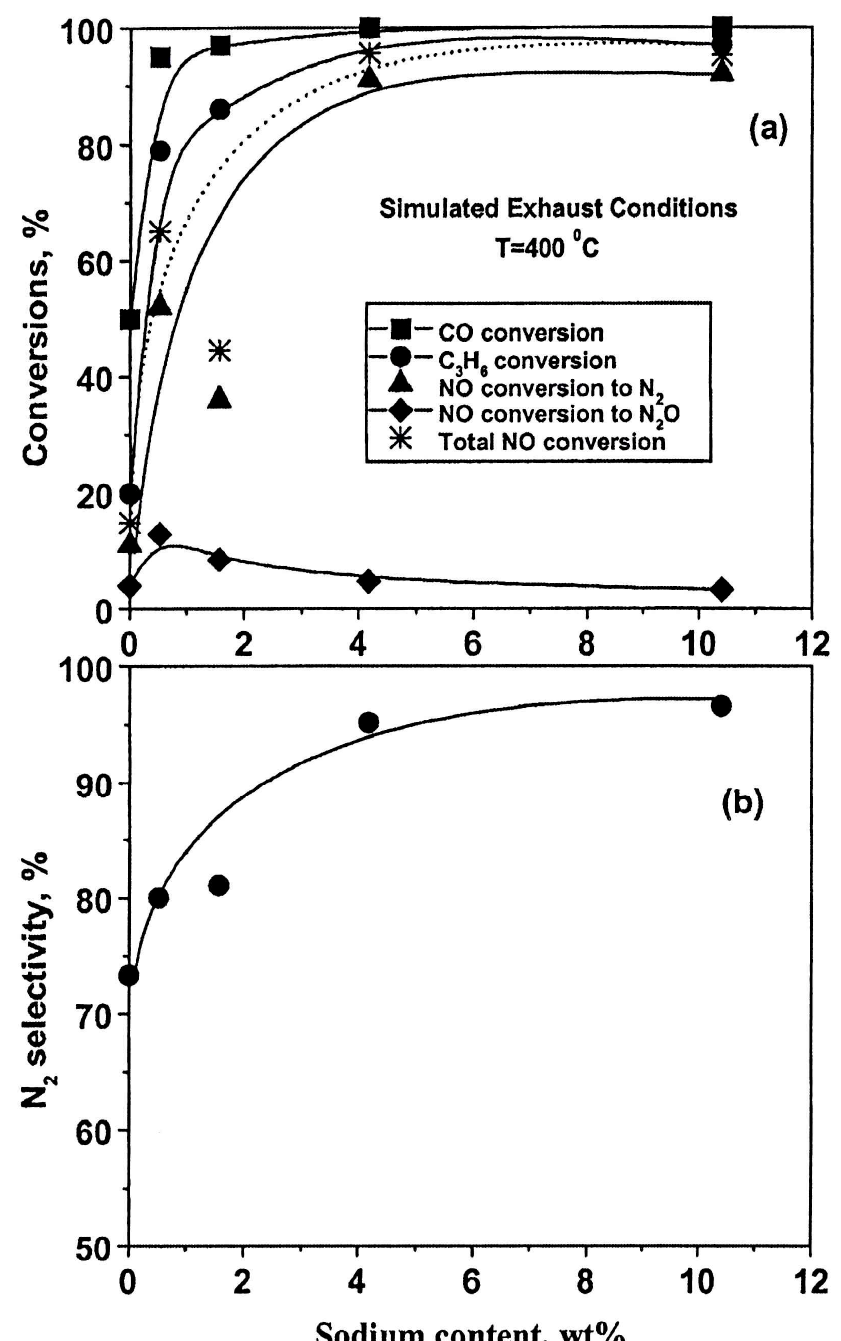
Figure 15. Testing Na-promoted Pt/ γ -Al 2 O 3 catalysts at simulated exhaust conditions of conventional stoichiometric gasoline engines (T=400 °C, 1000 ppm NO, 1067 ppm CO and 7800 ppm O 2 ; F t = 80 cm 3 STP/min; m cat = 8 mg). Effect of Na loading on reactants conversions ( a ) and selectivity towards N 2 ( b ). (Reprinted with permission from Ref. [89]; Copyright 2000,